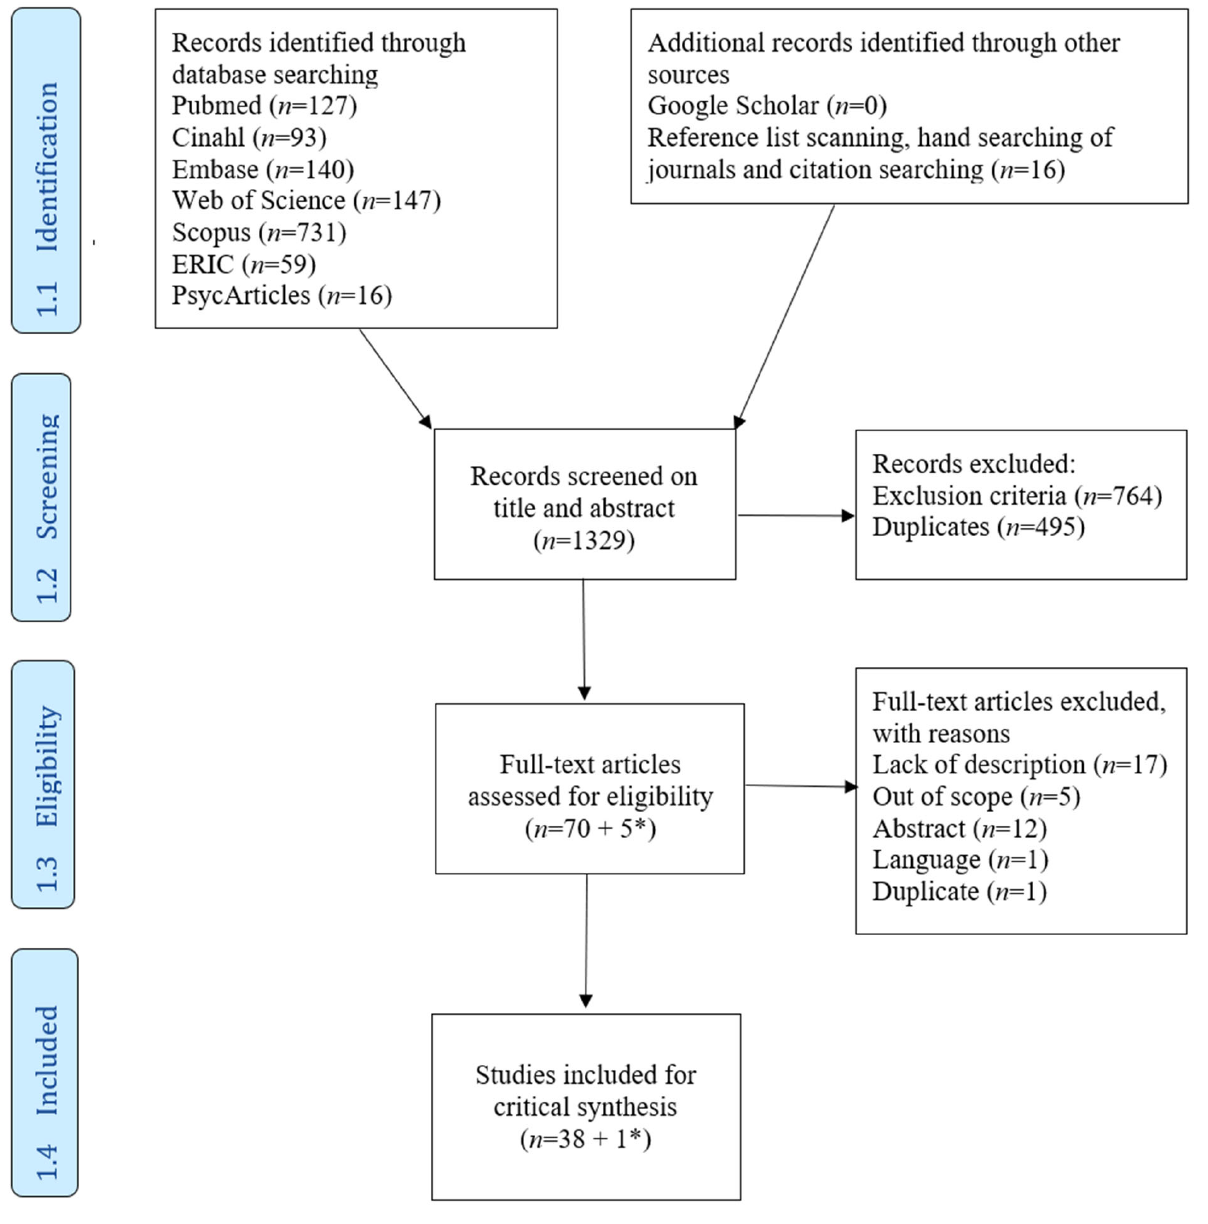
Figure 1. PRISMA flowchart of included studies after the second and third literature search (* represents the articles that were added after the third literature search).